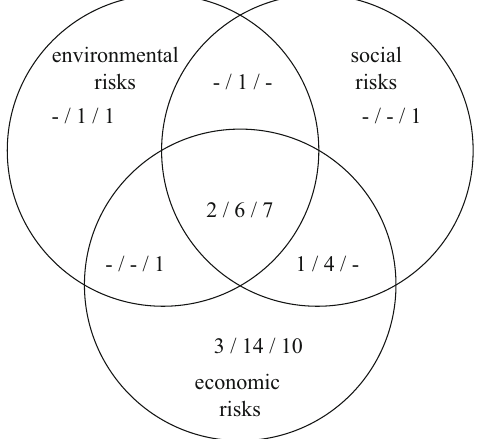
Fig. 5 TBL risks in